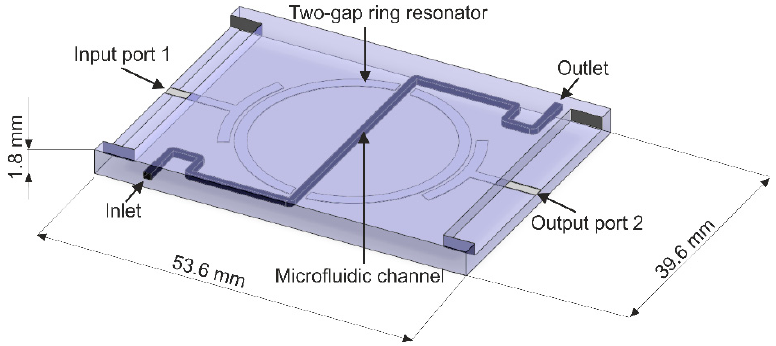
Figure 1. A computer-aided design (CAD) model of the two-gap ring resonator